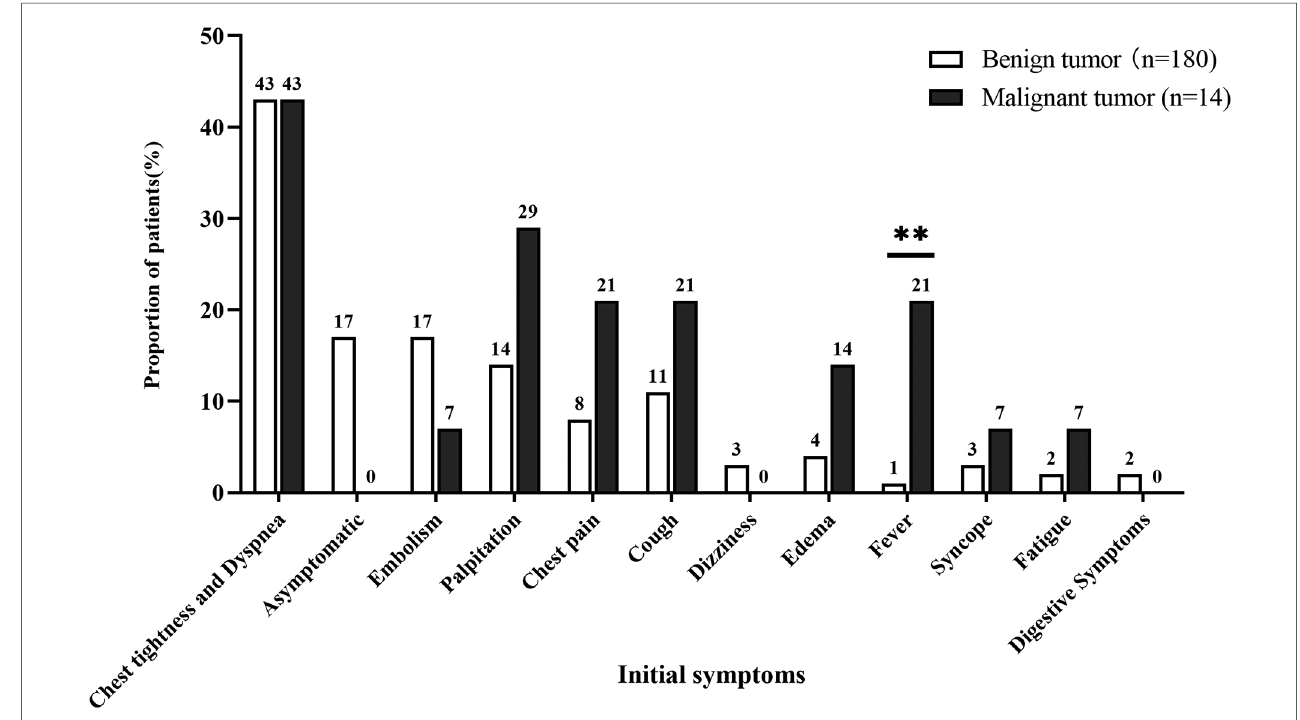
FIGURE 2 Comparison of initial symptoms between patients with benign and malignant primary atrial tumors. ** represets P